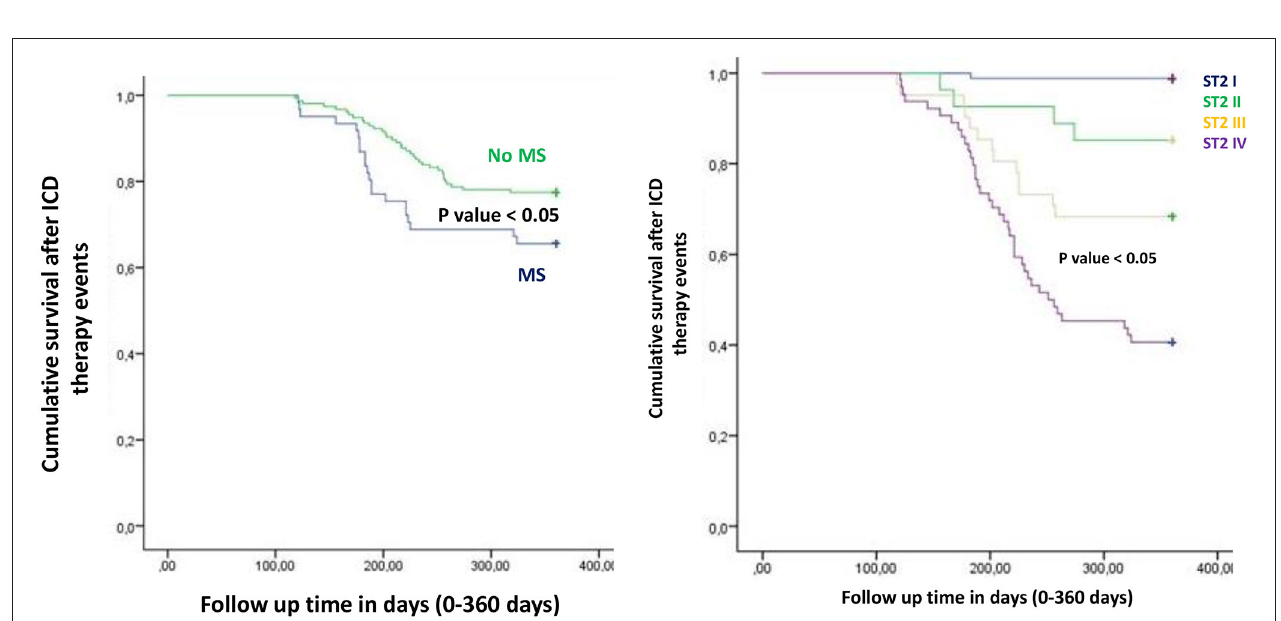
FIGURE 5 | The curve representation of “cumulative survival from ICD appropriate therapy events” (on y axis) during 360 days follow up (on x axis) comparing MS vs. no MS patients (left part), and different quartiles (right part).